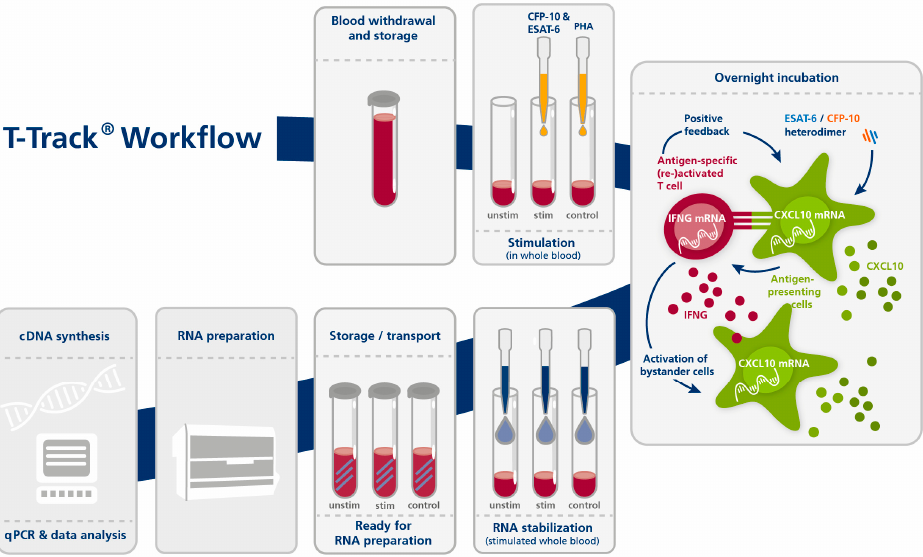
Figure 1. Principle and workflow of the T-Track ® TB assay. Abbreviations: cDNA, complementary DNA; control, stimulation control (PHA-stimulated); ESAT-6, Early Secreted Antigenic Target 6 kDa (TB antigen); CFP-10, Culture Filtrate Protein 10 (TB antigen); CXCL10, C-X-C motif chemokine